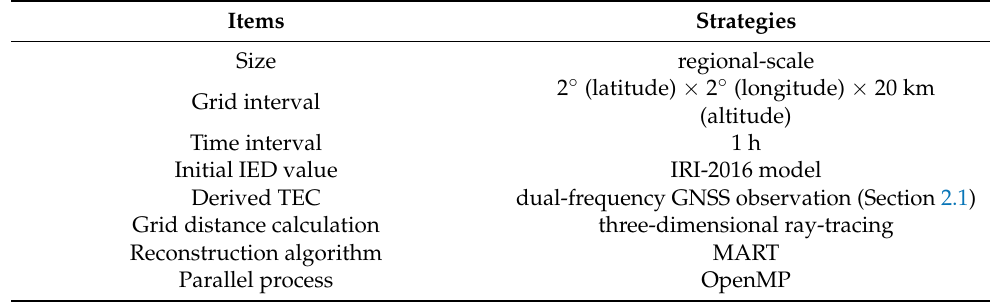
Table 1. Data processing strategies of 3D IED reconstruction. MART, Multiplicative Algebraic Reconstruction